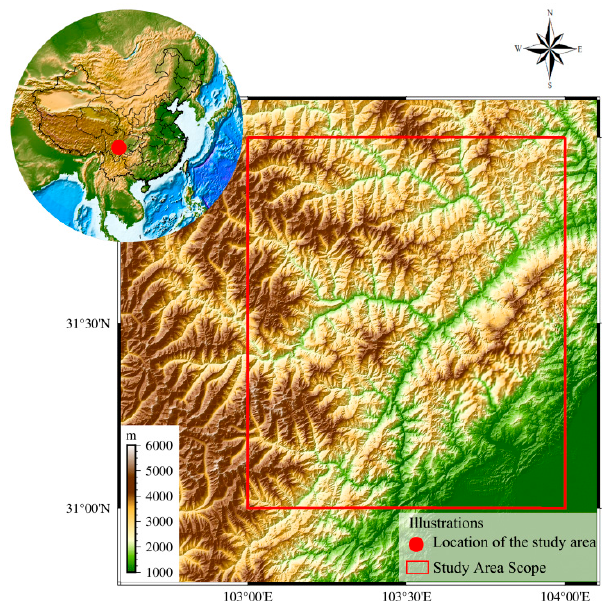
Figure 5. Overview of the study area.